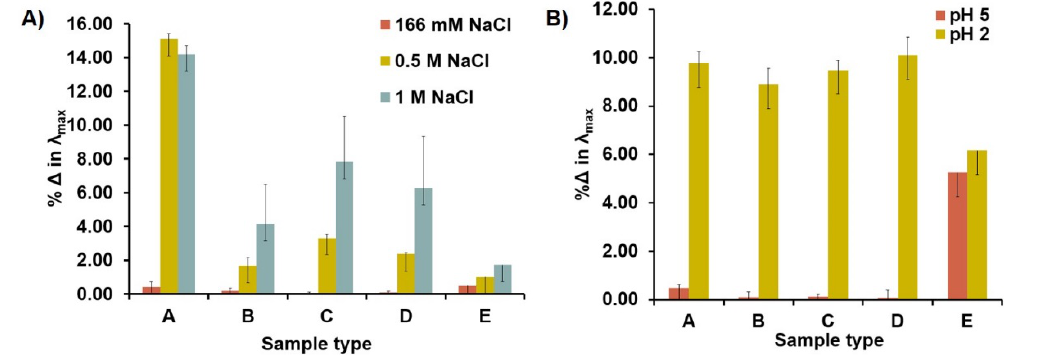
Figure 7. Percent change in λ of peptide-stabilized AuNPs after ( A ) exposure to 0.17 M, max 0.5 M, or 1 M NaCl in 10 mM sodium phosphate buffer pH 8.0 and ( B ) after adjustment of pH to 2 and 5 with 2 M HCl (aq). The sample types are: A) Au-GSH, B) Au-GSH-(His) C) Au-GSH-(Met) , D) Au-GSH-(Trp) , and E) Au-GSH-(DanArg) 2 2